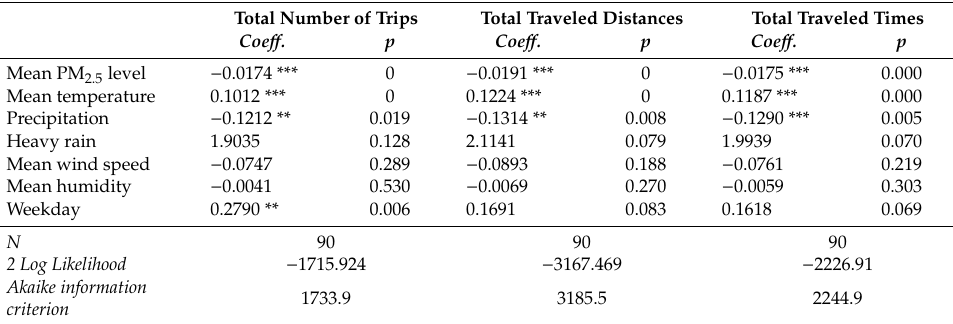
Table 12. Estimation results for bike sharing use using PM 2.5 level data in winter.